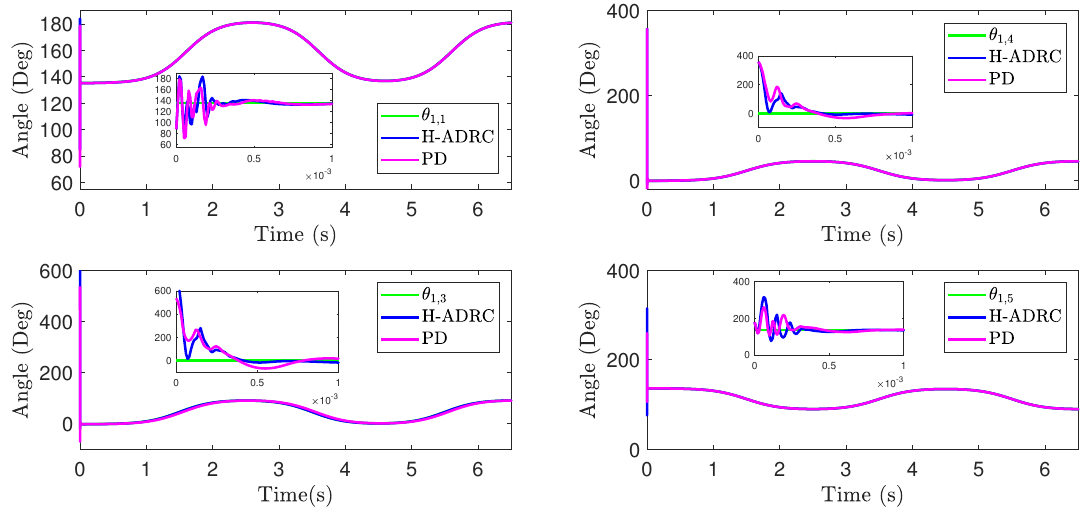
Figure 7. Comparison of reference trajectories with controlled states implementing either the PD and the proposed H-ADRC